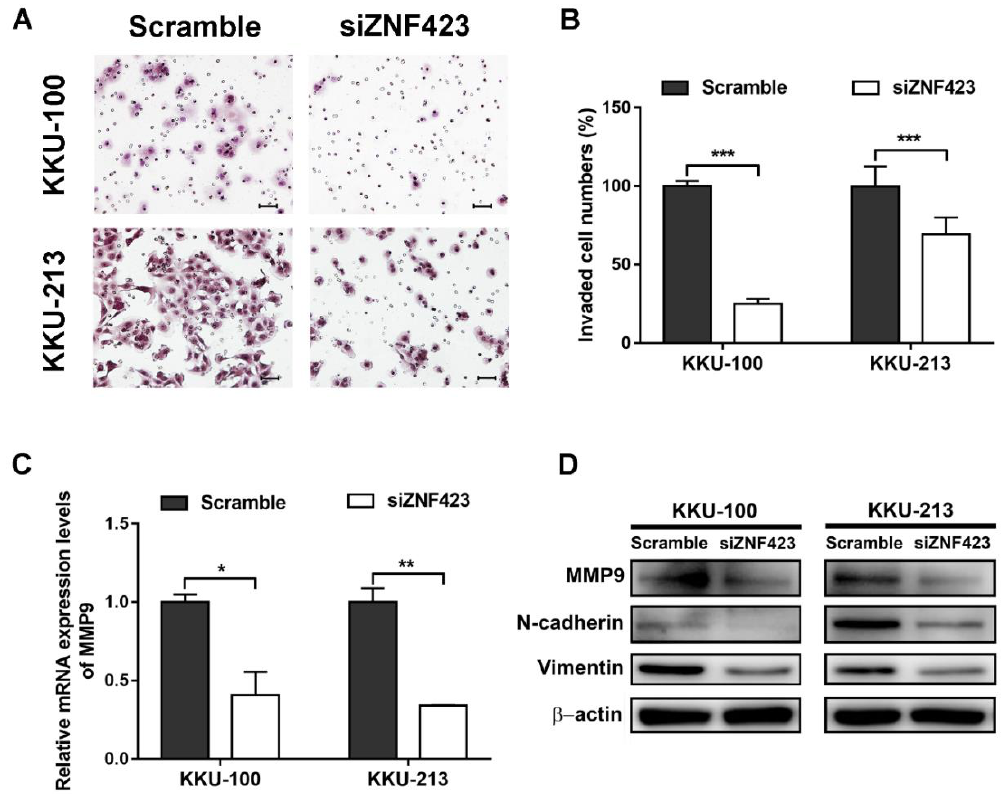
Figure 4. ( A ) Invasion of CCA KKU-100 and KKU-213 cells transfected with siRNA targeting ZNF423 and non-targeting scrambled controls. Scale bar is equal to 50 µm. ( B ) Representative percentage of invaded cells in KKU-100 and KKU-213 ( n = 2 per condition). ( C ) MMP9 mRNA expression levels of siRNA-treated and scramble-treated KKU-100 and KKU-213 cells were determined using qPCR ( n = 2 per condition). ( D ) Western blot analysis of MMP9 (~92 kDa), N-cadherin (~130 kDa), vimentin (~54 kDa) and β -actin (~42 kDa) protein expression levels. P -values were calculated by Student’s t test compared with scramble conditions (* p < 0.05, ** p < 0.01, and *** p < 0.001).